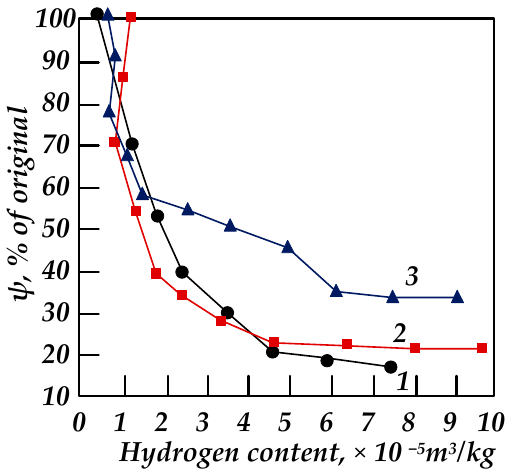
Figure 5. Influence of hydrogen contained in steel on the relative narrowing of steels 34KhM (1), 34KhN2M (2), and 34KhN3M (3) [26].